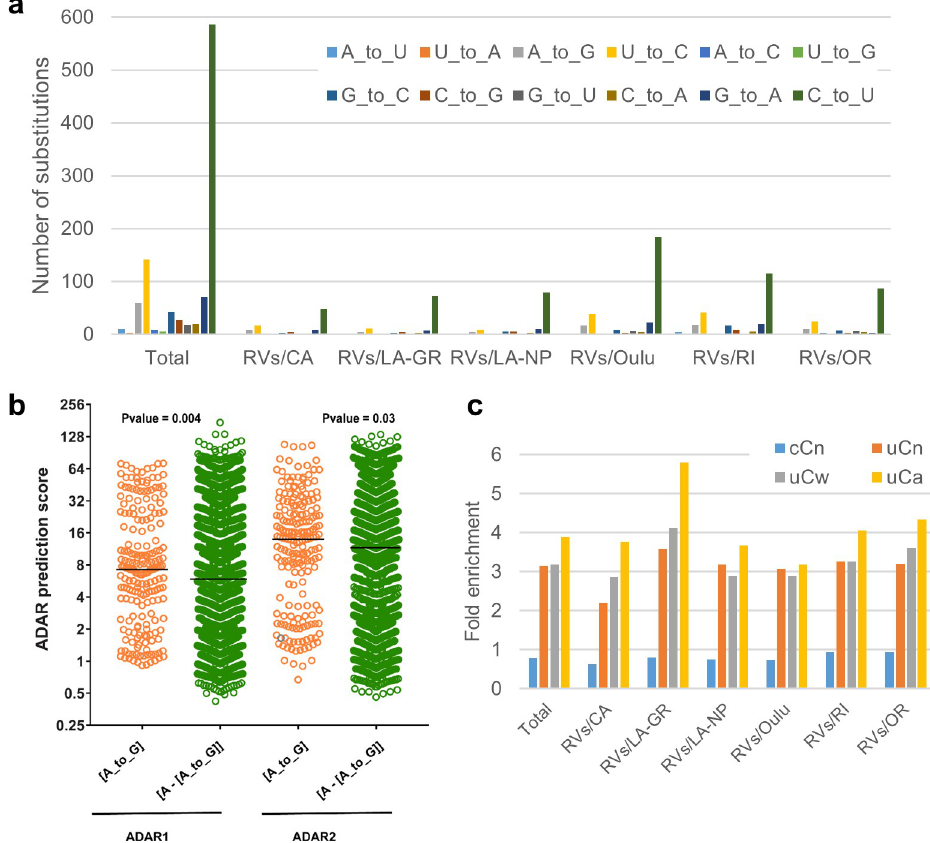
Fig 6. RNA editing signatures in iVDRVs. a. Spectra of single-nucleotide substitutions in iVDRV RVs genomes. Underlying data for Fig 6A–6C can be found in the S6 Data file. b. ADAR1 and ADAR2 prediction scores for adenines. The scores were calculated for 60 [A to_G] mutations in the positive strand and for 141 [A_to_G] mutations in the negative strand of the viral genome, as well as for the adenines that mutated to bases other than guanines along with adenines that did not mutate at all ([A–[A_to_G]]) (Note: Since, by convention, all mutations in S6 Data file are listed as changes in the positive strand, the negative strand [A to G] mutations are presented in this Table as [U to C] changes in the positive strand). The y axis denotes the prediction scores of hADAR1 and hADAR2 activity expressed as log2. The black horizontal line in the graphs denotes the median value of the prediction scores. P-values are shown above the scatter plots. c . Enrichments with APOBEC editing motifs in iVDRV RVs genomes. Mutated nucleotides are shown in capital letters within trinucleotide mutation motifs. Enrichment values were calculated for C to U mutations induced in the RV positive strand as described in Methods. P-values of one-sided Fisher’s exact test calculated as described in [37] can be found in the tab “Fisher_test_Fig6C” of S6 Data file.